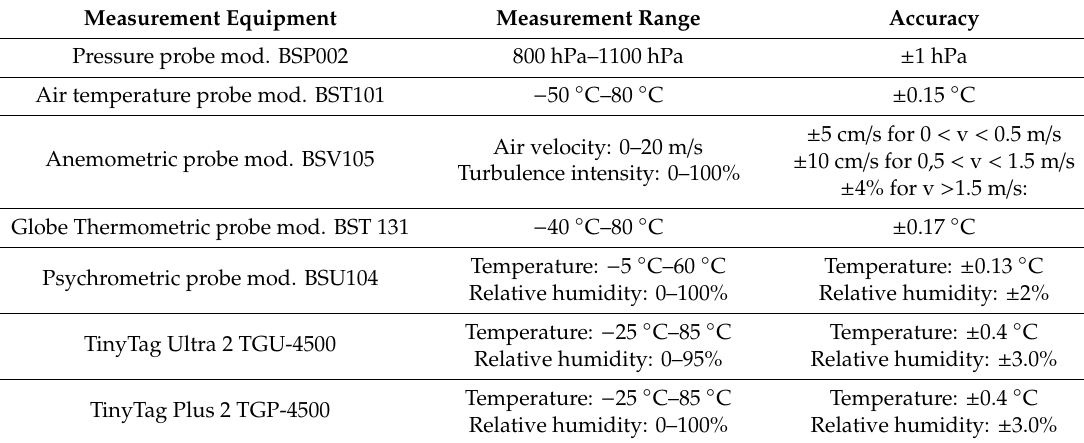
Table 2. Technical specification of the equipment employed for the experimental